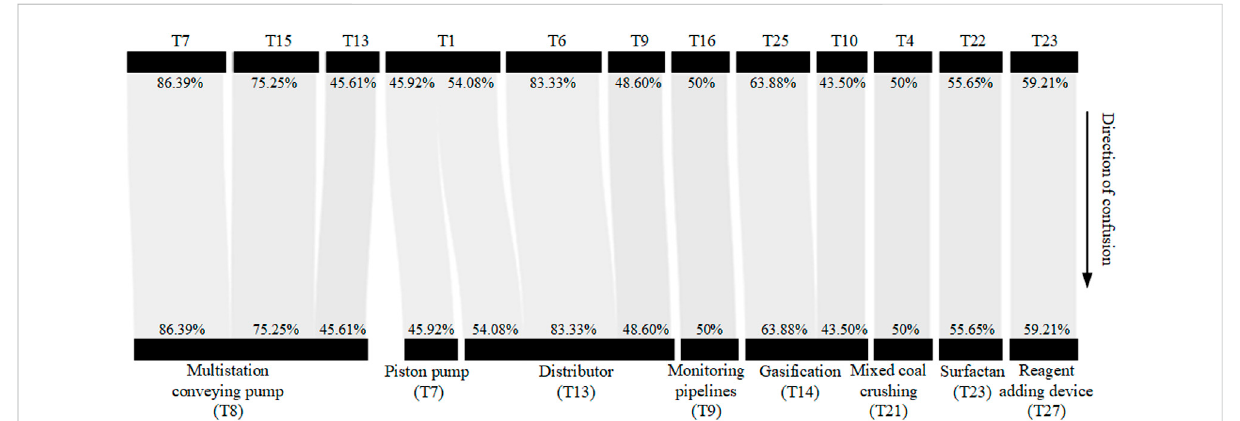
FIGURE 3 The confusion process between technology